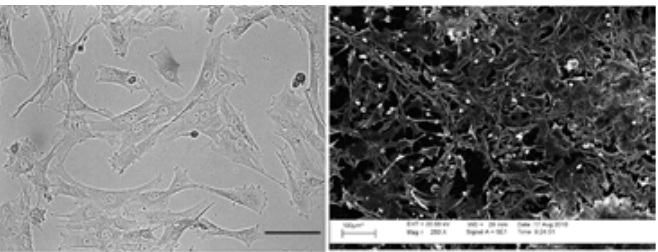
FIGURE 1 – Culture of mesenchymal stem cell in forth passage, with higher cell confluence and fibroblastoid-like cells adhered to the substrateand the culture flask. A . Photomicrograph captured of inverted optical microscope (escale=50µm). B . Photomicrograph captured of scanning electron